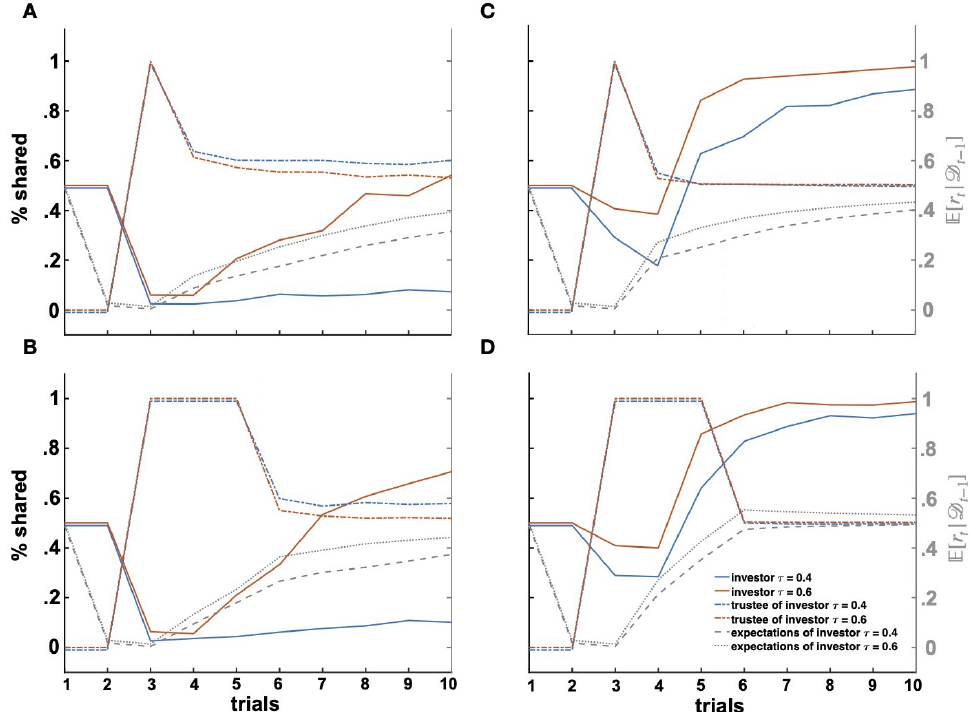
Figure 6. Effects of loss aversion on repair of trust. Repair of trust after initial uncooperativeness (trials 1–2) with loss-averse investors without ( A ) and with ( B ) a coaxing trustee and with loss- insensitive investors without ( C ) and with ( D ) a coaxing